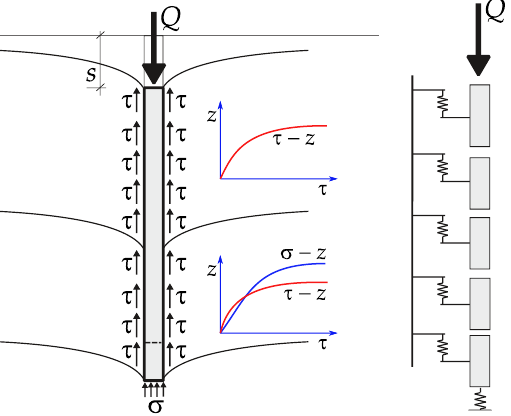
Figure 2. Application of load transfer functions in axially loaded pile analysis.